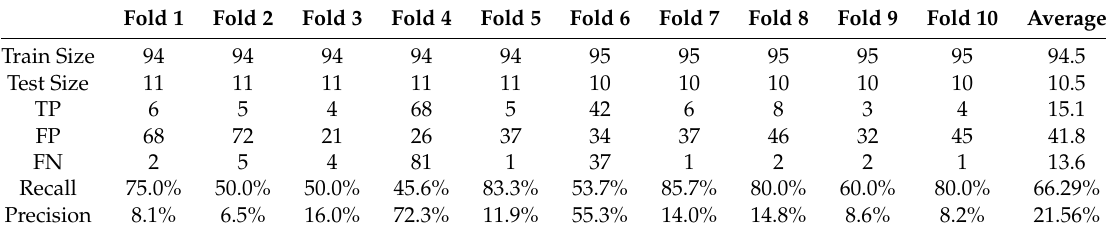
Table A1. The Results of Experiment 1: Adding images without dents (Dataset 1).